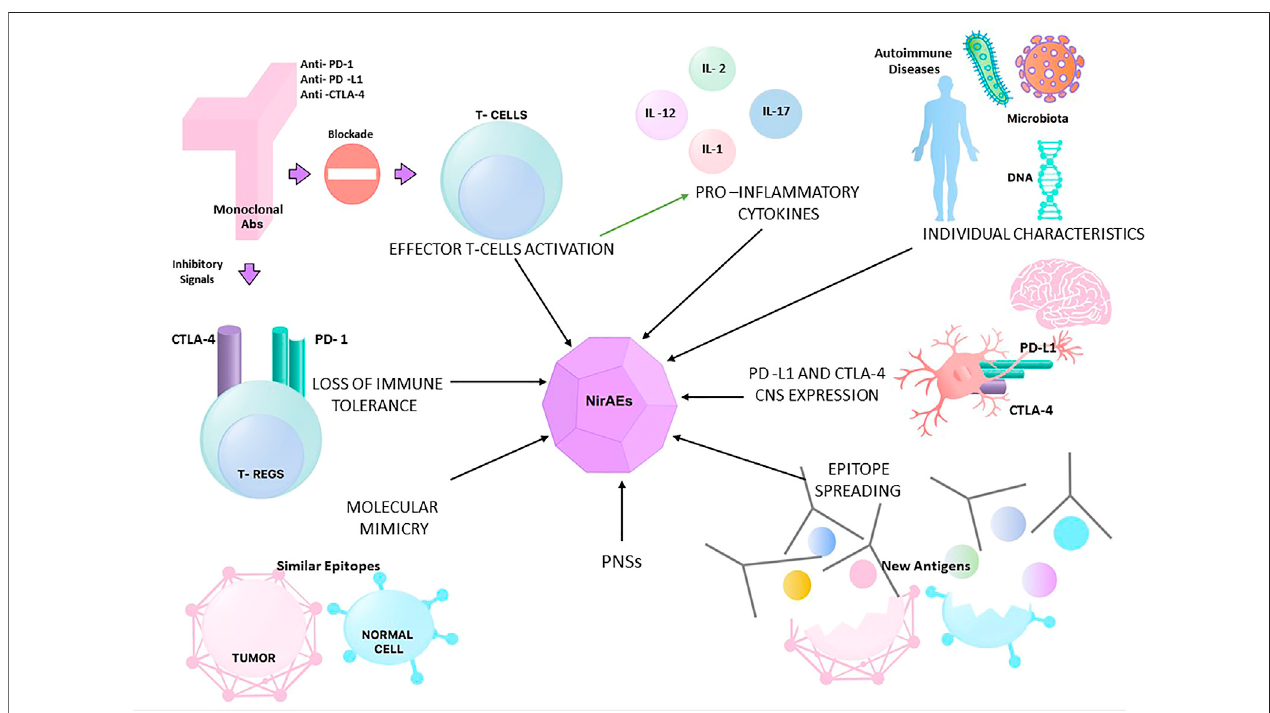
FIGURE 1 | Different hypotheses for the physiopathology of neurological immune-related adverse events (NirAEs). PNSs , paraneoplastic syndromes.